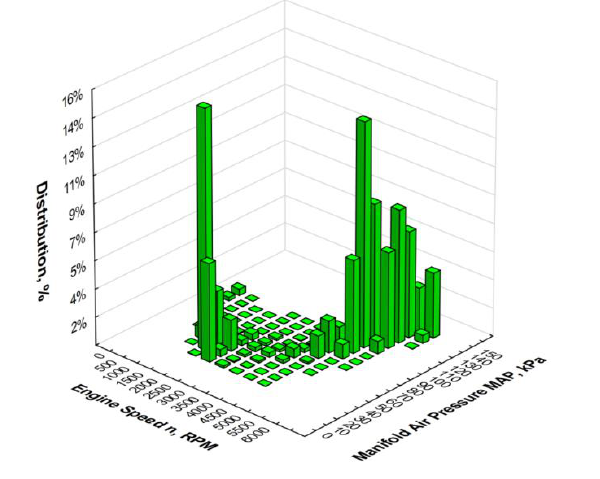
Fig. 4. Distribution of engine operating points during training